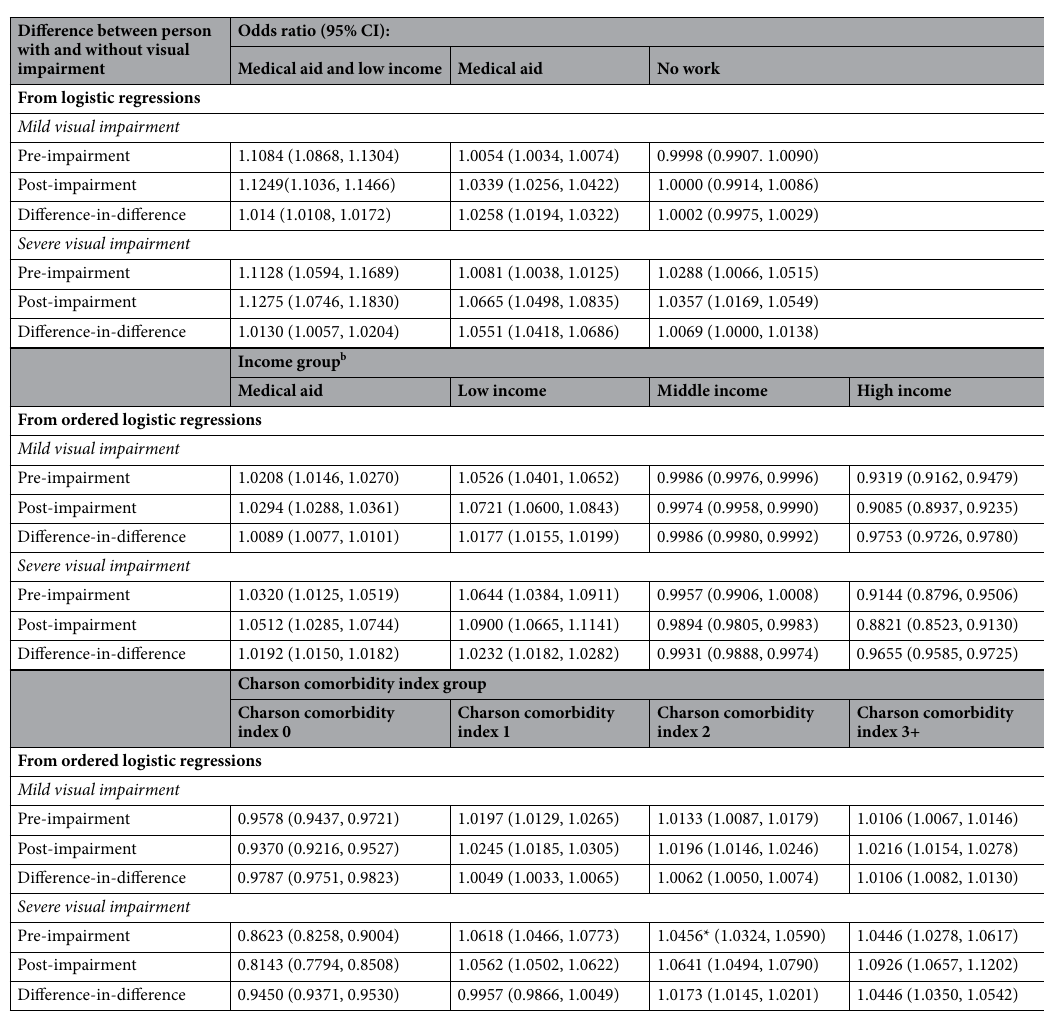
Table 3. The estimated effect of visual impairment on socioeconomic and health status by severity of impairment (N = 751,812). a p < 0.10, ** p < 0.05, *** p < 0.01. b Medical aid, Low income (1st to 4th deciles), Middle income (5th to 8th deciles), High income (9th to 10th